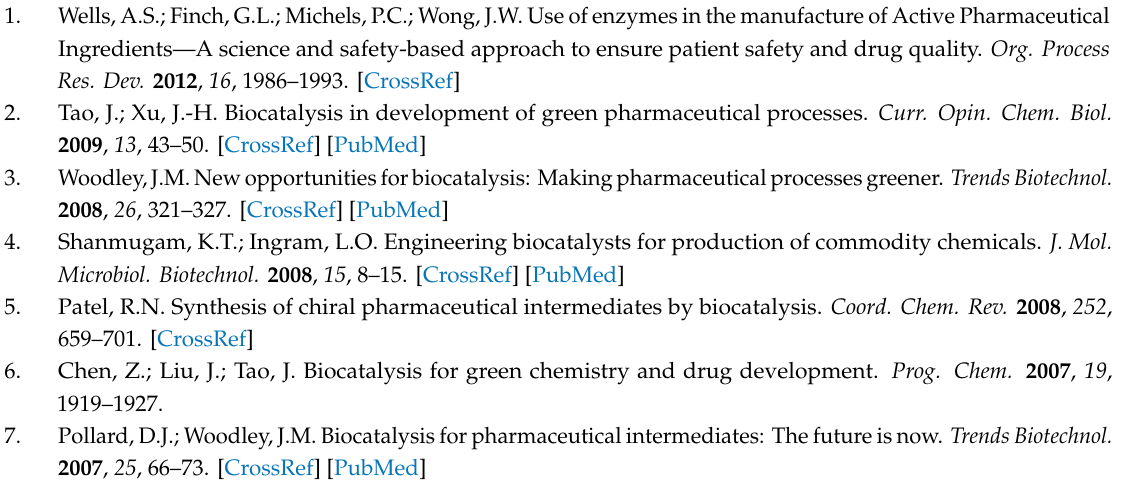
Figure S1: Stability of soluble and immobilized PGA, Figure S2: Synthesis of Cefazolin ( 2a ) catalyzed by recycled PGA immobilized on Relizyme EP403 / S-glucosamine, Figure S3: Stability of soluble bromelain at pH 10 and 4 ◦